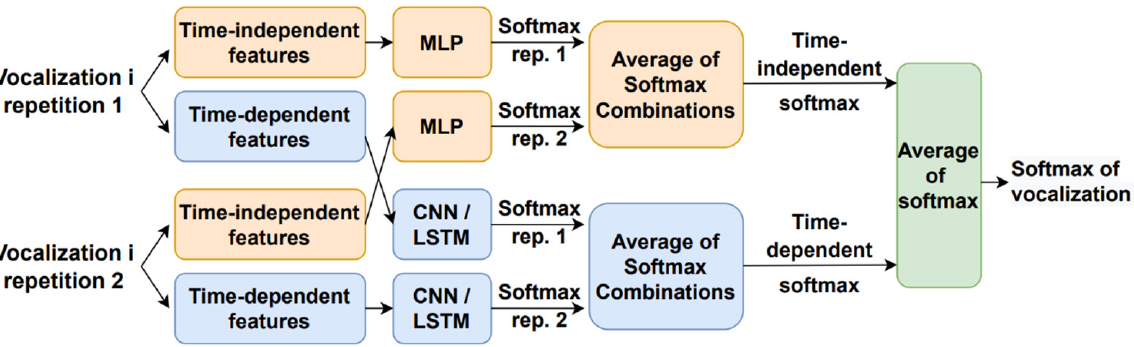
Figure 1. Block diagram of the proposed system. Figure 2. Estimation of the vocalization dependent scores.